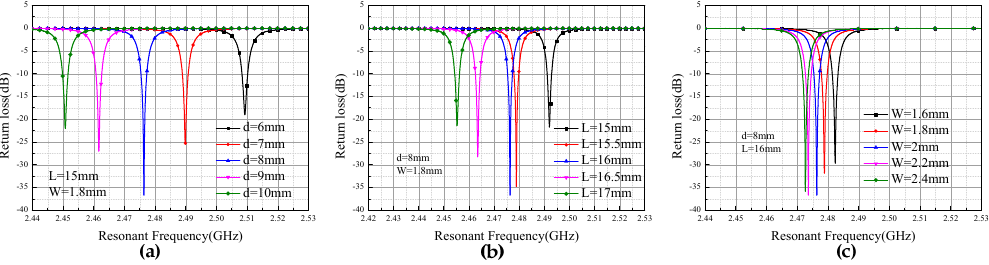
Figure 5. HFSS simulation results of ( a ) position d ; ( b ) aperture length L ; and ( c ) aperture width W.